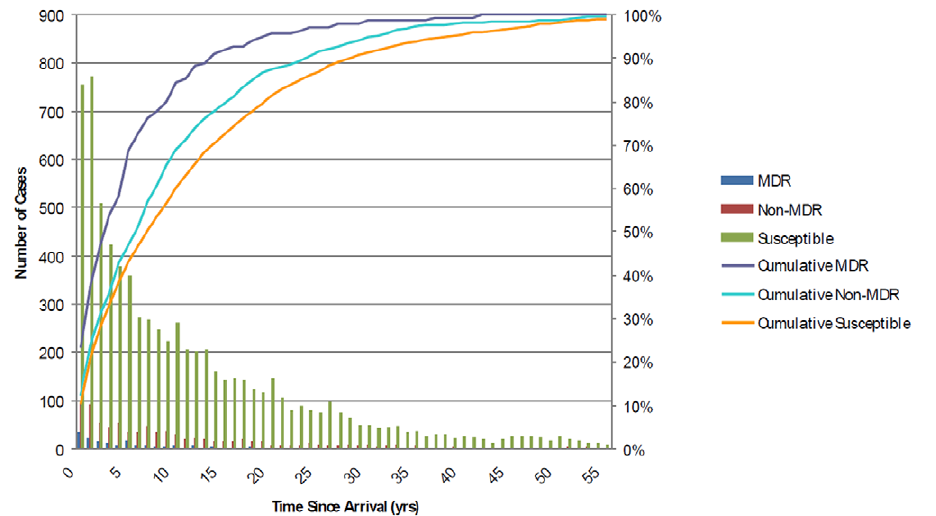
Figure 2. Time from arrival in Canada to diagnosis of foreign-born culture-positive tuberculosis cases by drug susceptiblility pattern of incident case isolate (1997–2008). Time from arrival to diagnosis was calculated by subtracting year of arrival from year of diagnosis. Year of arrival was known for 6928 of the 10589 foreign born cases. Cases with time since arrival between 0–55 years displayed. Bar graph represents the absolute number of cases diagnosed, and line graph represents the cumulative proportion of foreign-born TB cases diagnosed since their time of arrival in Canada.